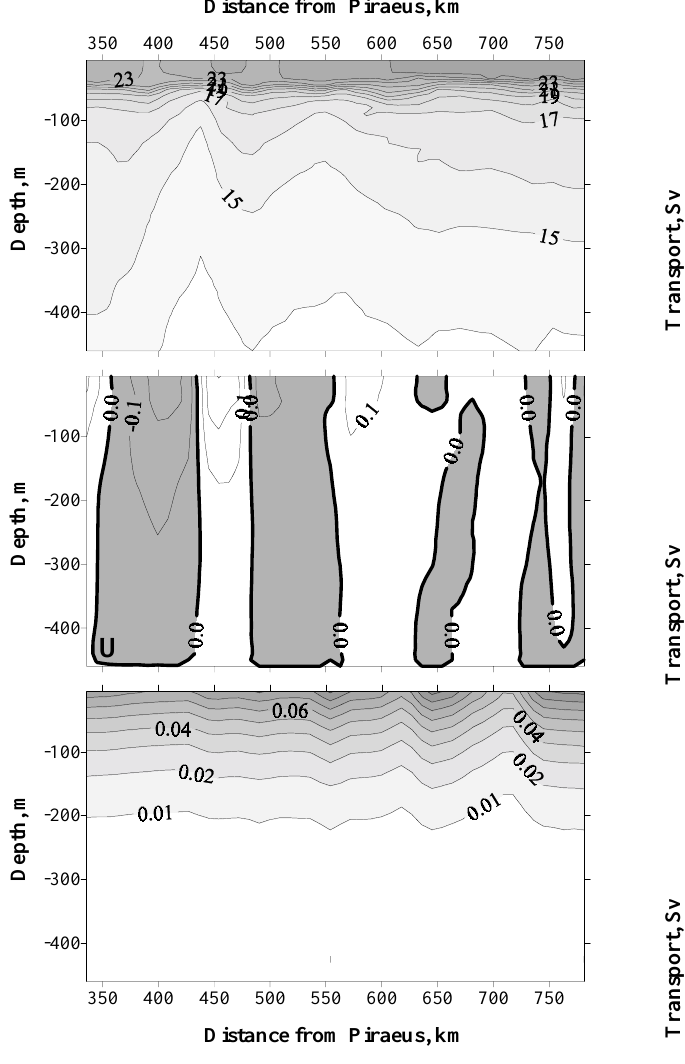
Fig. 7e. As in Fig. 7a, for the 14th crossing on 22 July 2000.